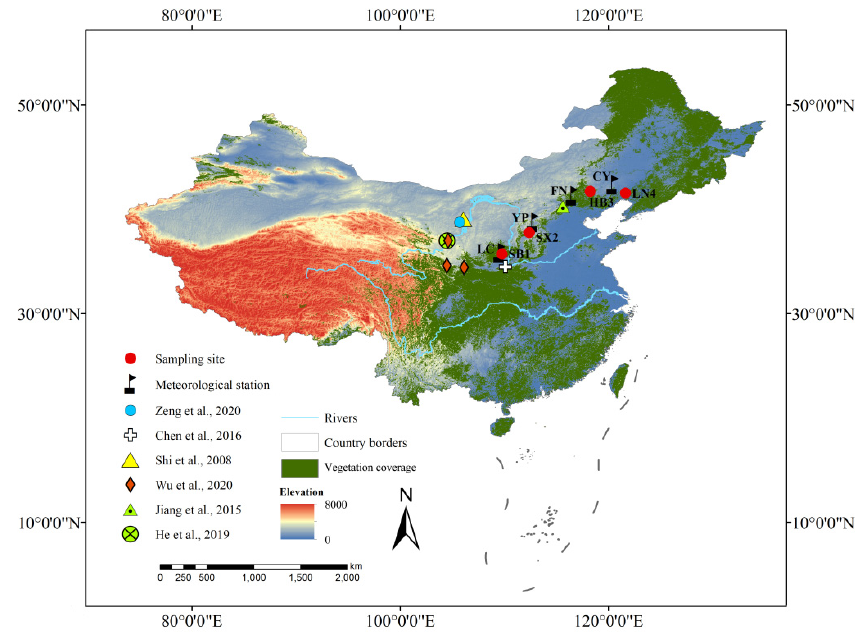
Figure 1. Locations of Pinus tabulaeformis tree-ring sampling sites (red dots: SB1, SX2, HB3, and LN4), meteorological stations (black flags: LC, YP, FN, and CY), and other sites marked by different symbols mentioned in this study.